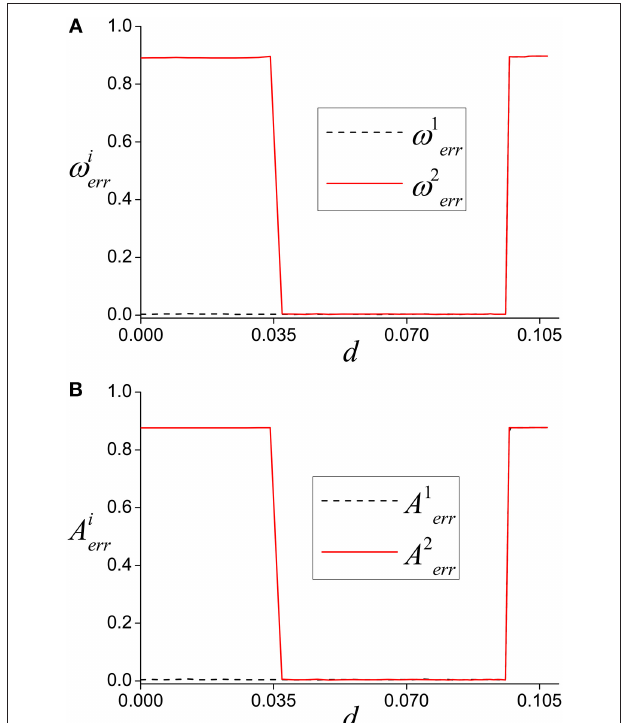
FIGURE 3 | Dependence of the maximum errors between the average frequencies ω i err (A) and amplitudes A i err (B) in the reference chimera state and the states occurring in first (dashed line) and second (solid line) layer. Parameters values: a = 0.32, b = 0.79, c = 1.166, ε = 0.001, d r = 0.006, and T c =